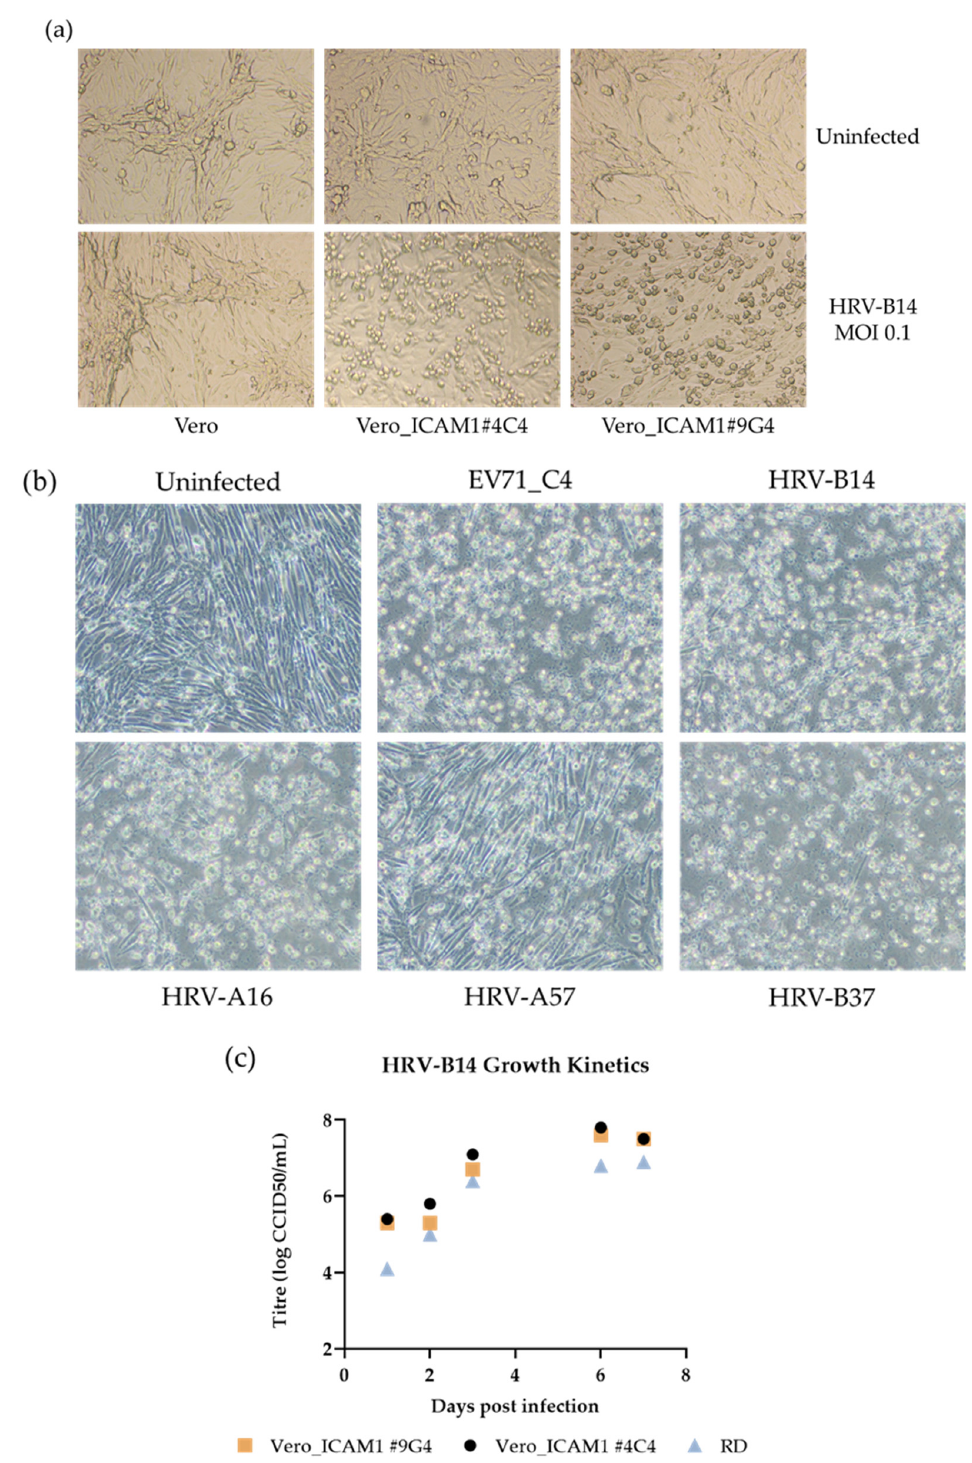
Figure 4. Vero_ICAM1#4C4 cells stably expressing ICAM1 can be infected with HRV-B14, HRV-A16, HRV-A57 and HRV-B37. ( a ) Infection of Vero_ICAM1#4C4 and Vero_ICAM1#9G4 with HRV-B14 at an MOI of 0.1 induces replication in the ICAM1-expressing clones, but not in the parental Vero cells, indicated by the presence of CPE in both clones; ( b ) HRV-A16, HRV-A57 and HRV-B37 can replicate in Vero_ICAM1#4C4 cells. HRV-B14 and EV71_C4 were included as positive controls; ( c ) growth kinetics of HRV-B14 infection on Vero_ICAM1#4C4, Vero_ICAM1#9G4 and RD cells after infection at an MOI of 0.01.